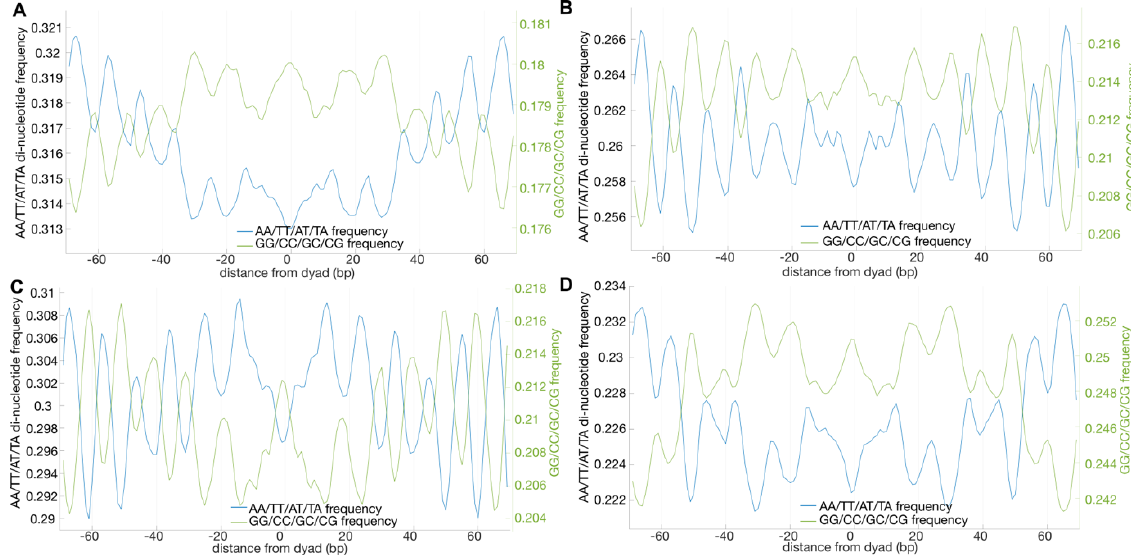
Figure 5: Repeated di-nucleotide patterns in nucleosomal DNA. Di-nucleotides frequency plots (average of three biological replicates) for Botrytis cinerea (A), Fusarium graminearum (B), Leptosphaeria maculans ‘brassicae’ (C), and Leptosphaeria maculans ‘lepidii’